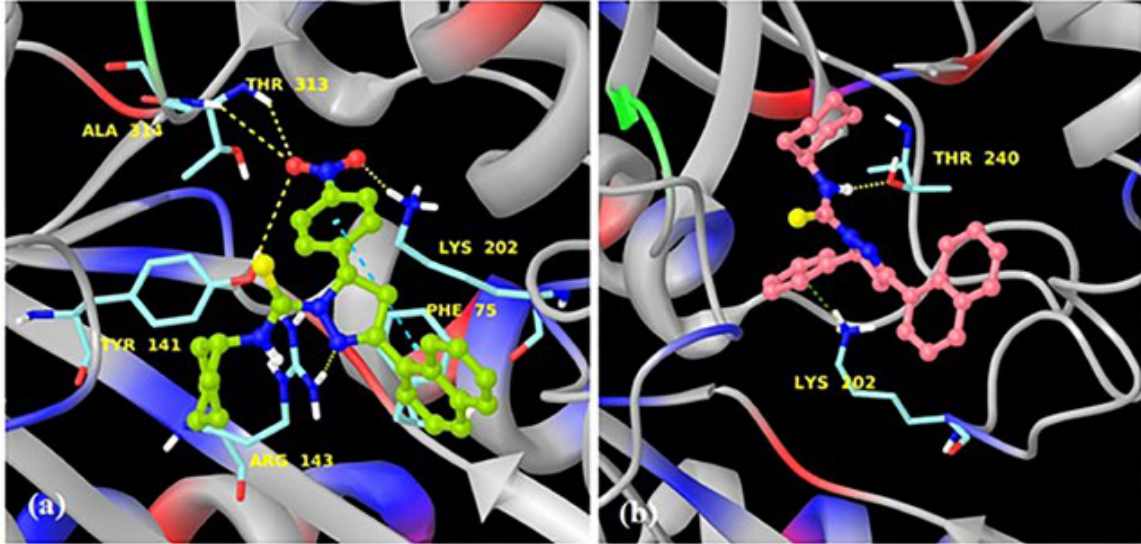
FIGURE 2 - (a) Docked pose of best ranked docking score of compound 4e (yellow green colour) represented as ball and stick in the binding site of hBCATc showing hydrogen bond interaction (yellow dash lines) (b) Docked pose of compound 4b (pink colour) represented as ball and stick in the binding site of hBCATc showing hydrogen bond interaction (yellow dash lines) and pi-cation interaction (green dash